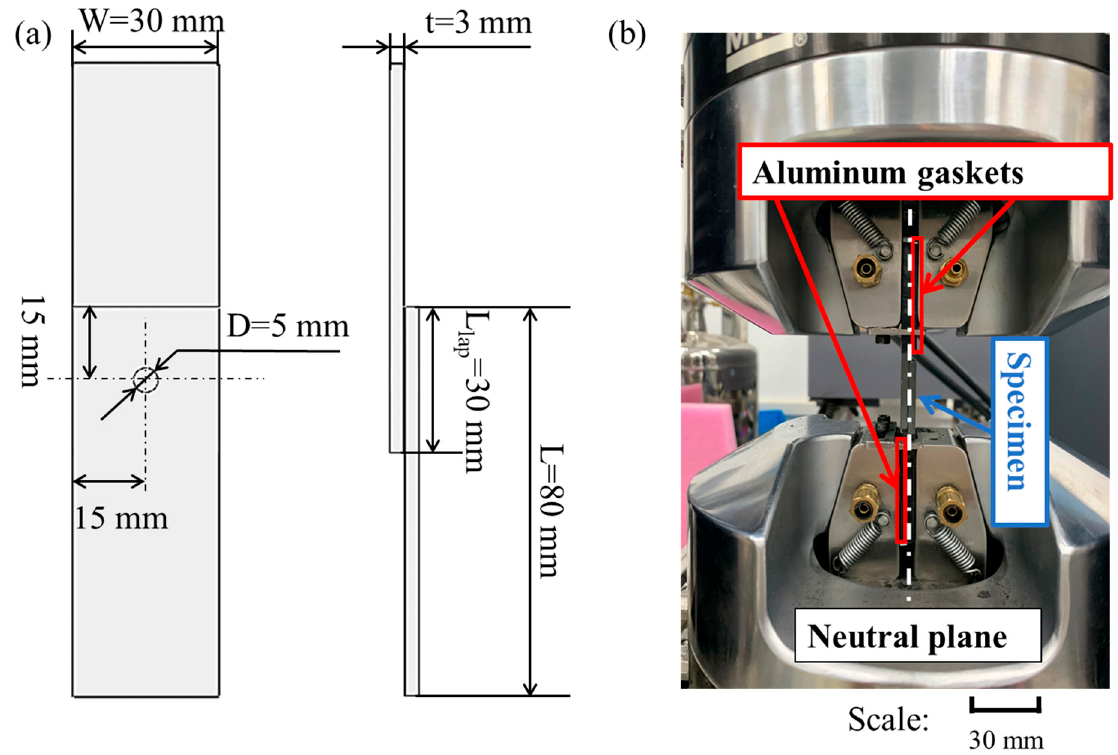
Figure 2. ( a ) Geometric parameters of the tested C/SiC joint; ( b ) Experiment setup.